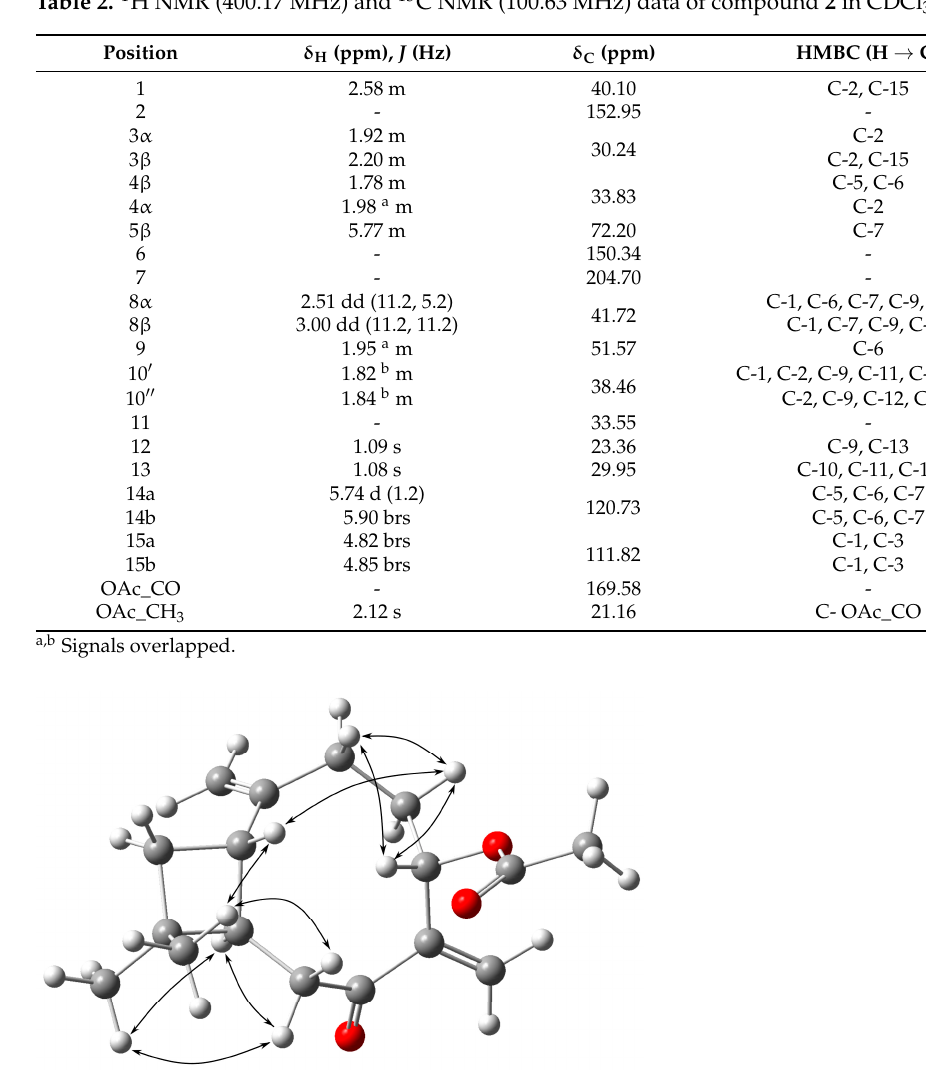
Figure 3. Key NOESY correlations for 2 . Table 3. Cytotoxicities of 10 and 11 against human normal and cancer cell lines after the 48 h treatment (5–100 µ